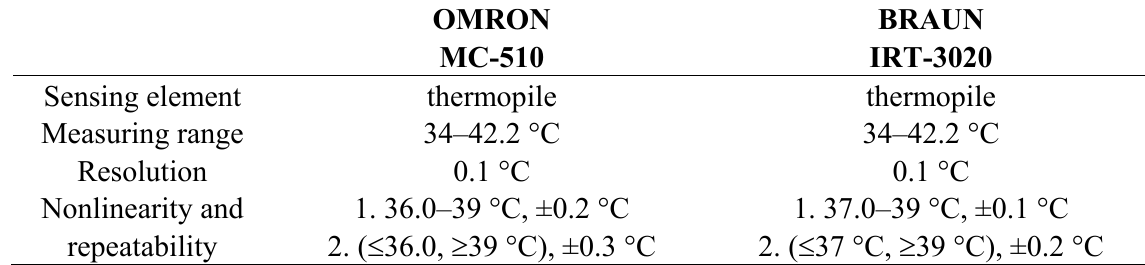
Table 1. Specification of the infrared clinical